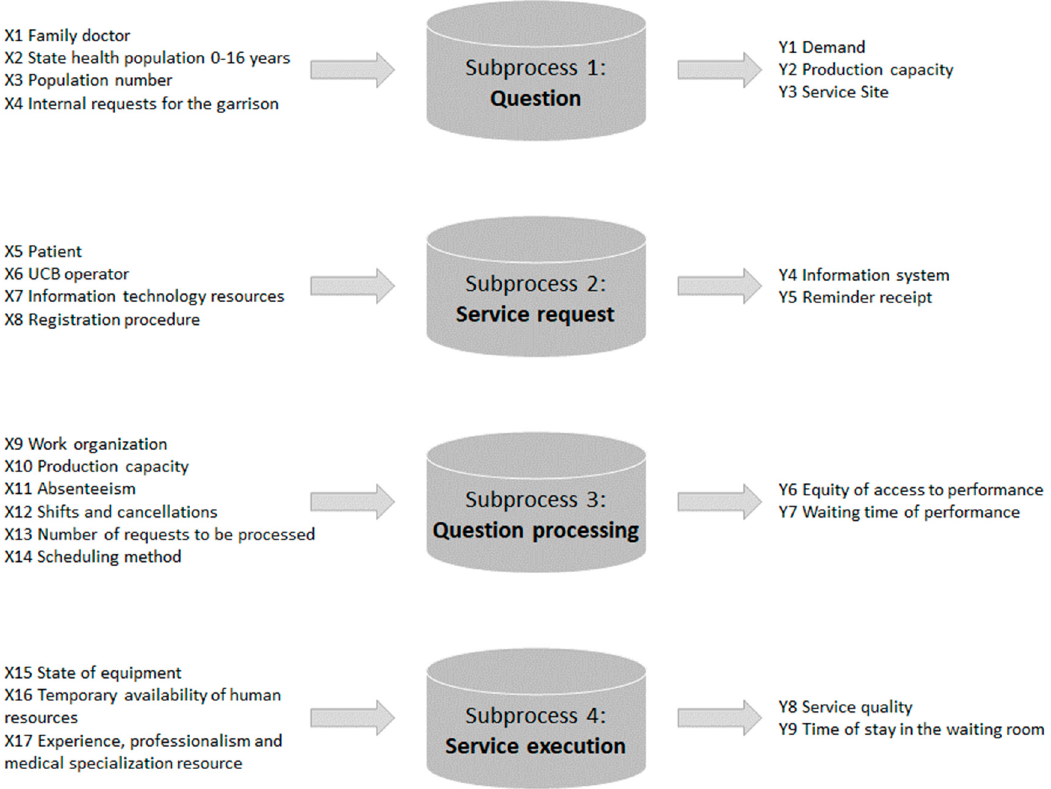
Figure 1. Map of the process.